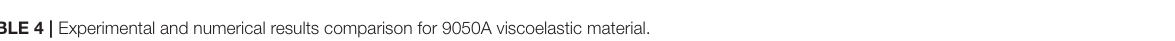
FIGURE 7 | The experimental and numerical results comparison of the viscoelastic damper when d = 1.0mm. (A,B) Storage modulus, and loss factor, respectively.